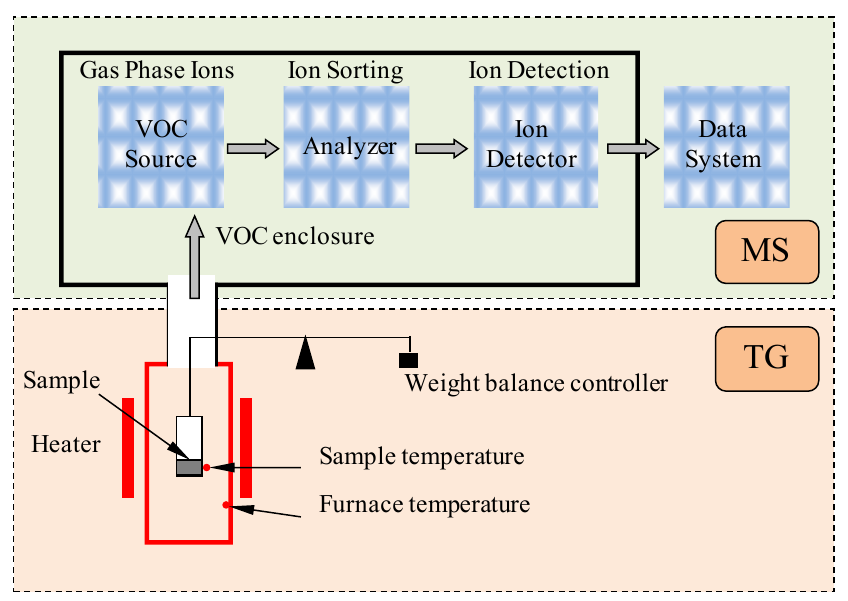
Figure 1. Principal of thermal gravimetric analysis-mass spectrometry (TG-MS) test and analysis program.